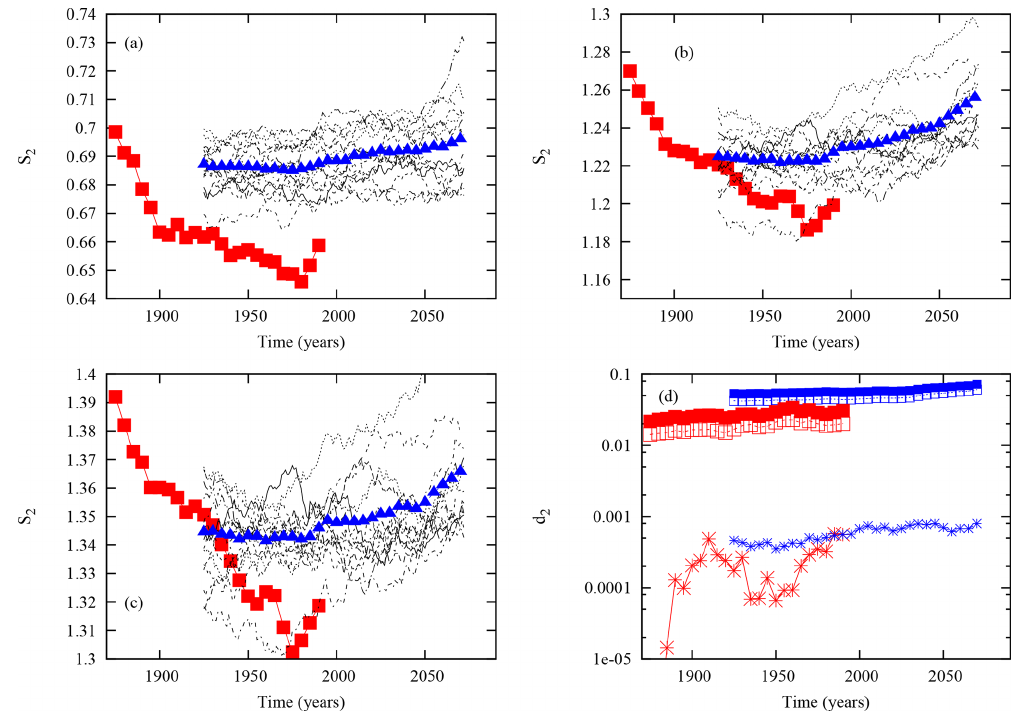
Figure 5. Temporal evolution of S 2 for the 15 model runs of the Met Office model from 1900 to 2099 under the RCP8.5 scenario (black lines) for (a) three patterns, (b) six patterns, and (c) eight patterns. The red curves represent the reference historical data and the blue triangle curve the average entropy over the 15 runs. (d) The lower bound of the information entropy production, d 2 , for the three regime partitions for the observations (red) and for the average information entropy production of the model runs (blue). The different symbols (star, open square, full square) correspond to the three partitions three, six and eight patterns, respectively.